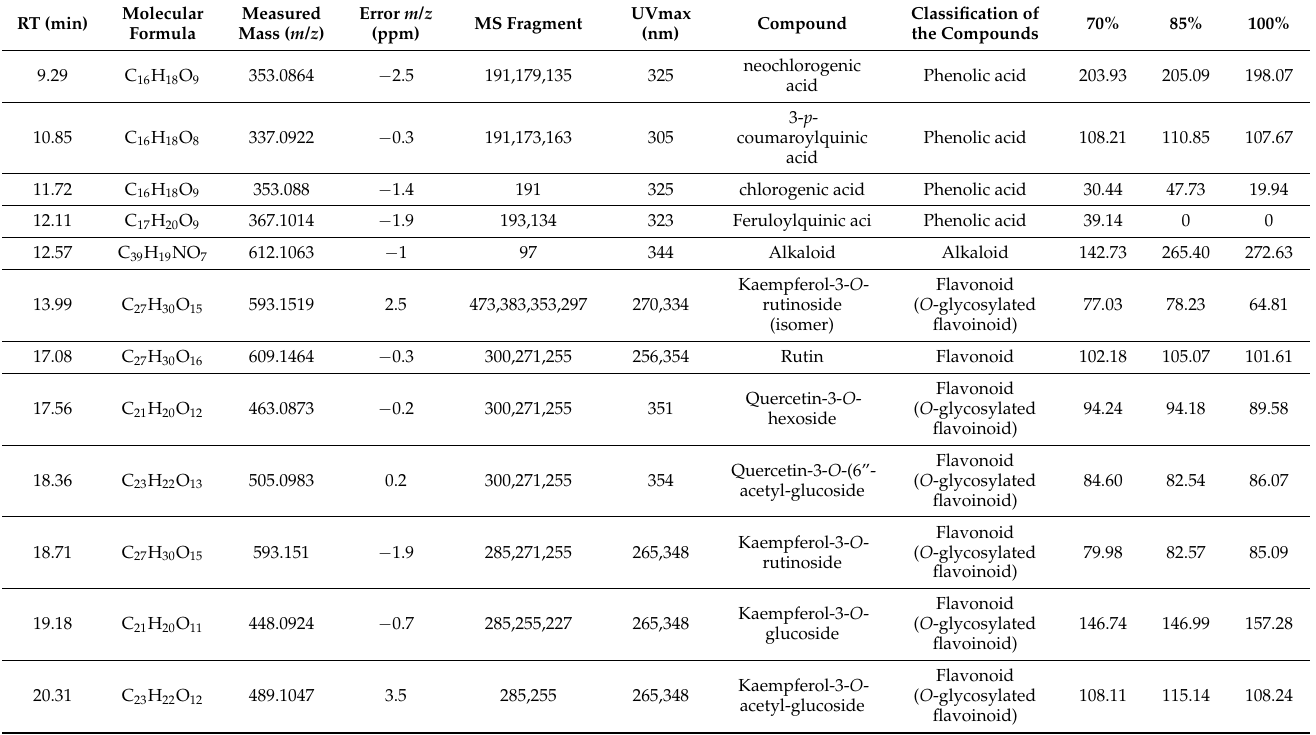
Table 4. Identification and mean abundance of phytochemicals (mg L − 1 ) in Moringa oleifera extracts using 70%, 85%, and 100%